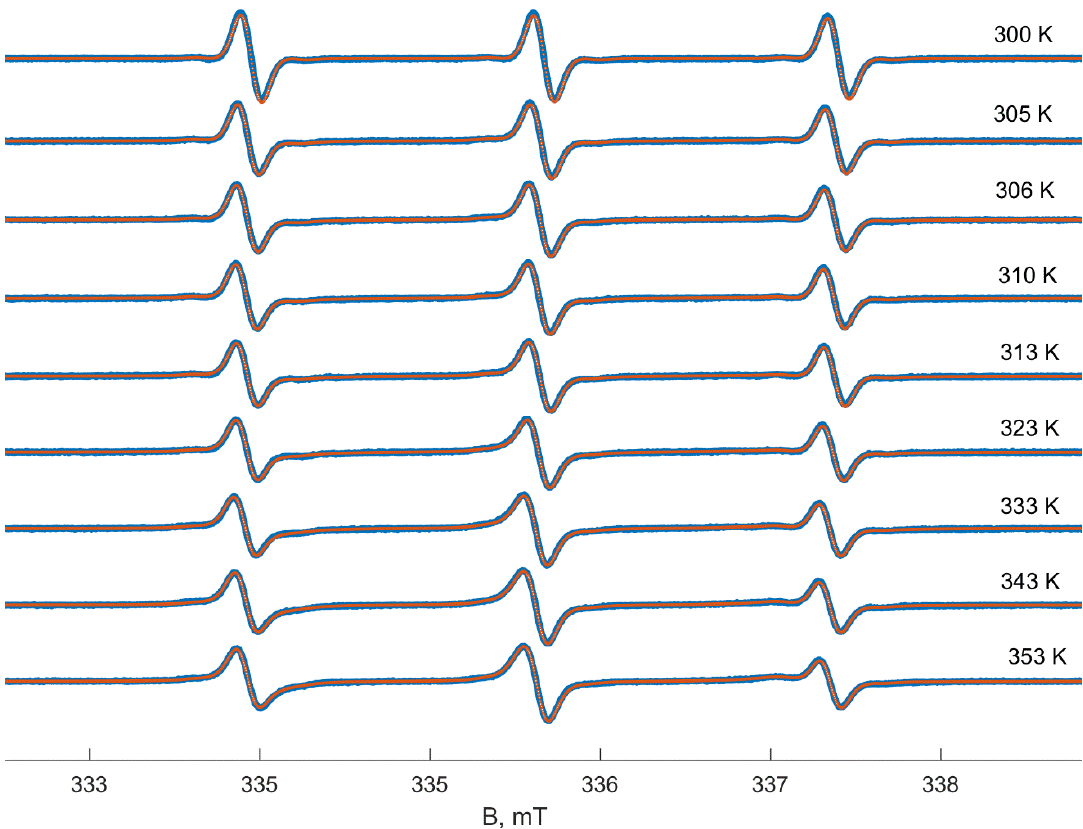
Figure A7. Simulation of spectra of system TEMPO/PNIPAM/H 2 O at different temperatures. Blue lines—experimental spectra, red circles—simulation spectra. Table A1. Selected spectral parameters from simulation TEMPO EPR spectra in 10 wt% aqueous solutions at 300–353 K.